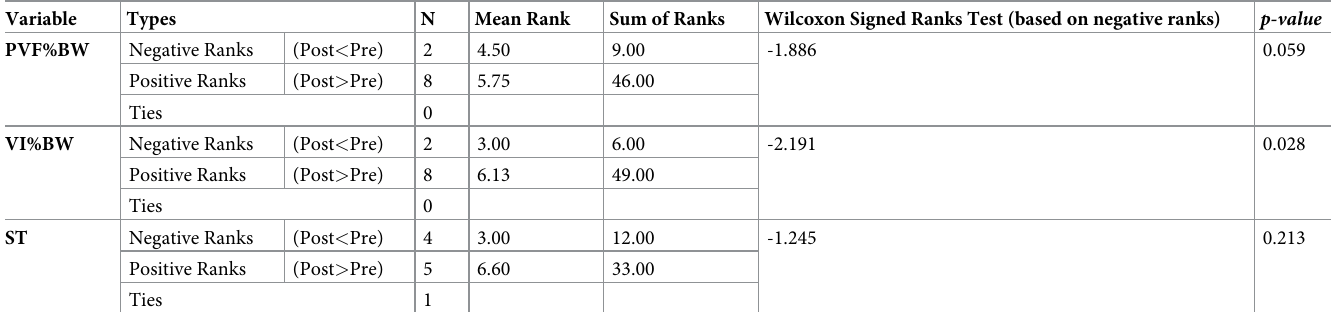
Table 4. GFRs: Ranks and Wilcoxon signed rank test values–group B: Product 2077.